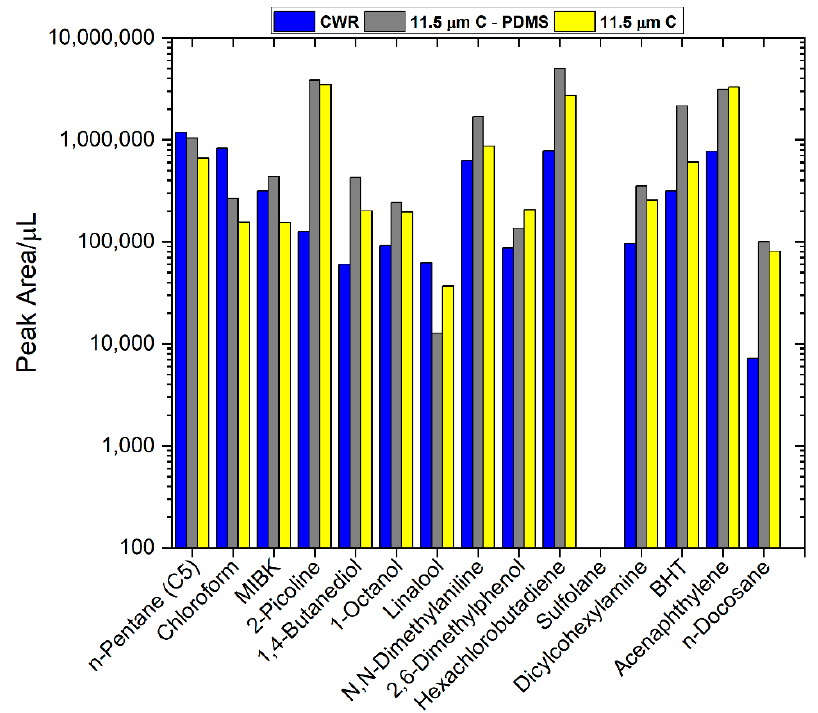
Figure 6. Volume normalized responses of DI – SPME – GC – MS results for 11.5 µm sputtered carbon SPME fibers and the commercial CWR SPME fiber. These are the same data as in Figure 5 in normalized form.